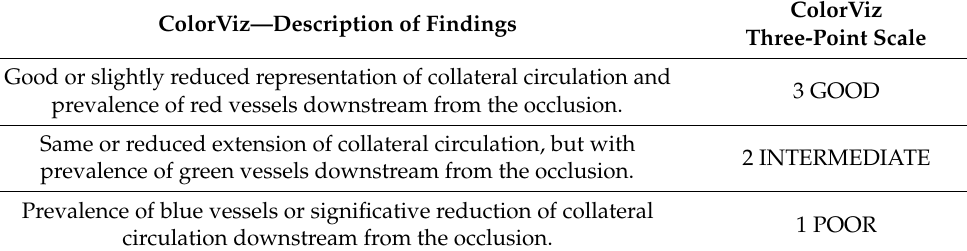
Table 1. ColorViz scores of collateral